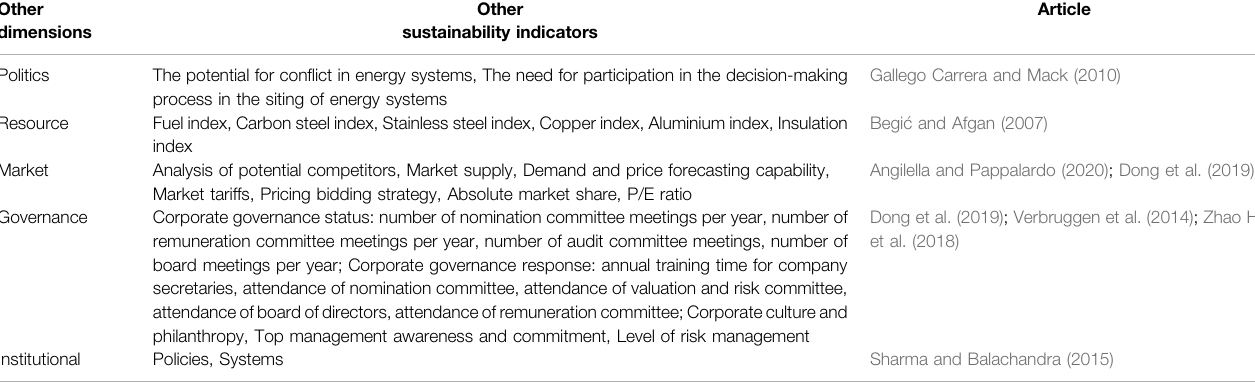
TABLE 11 | Summary of other sustainability indicators.